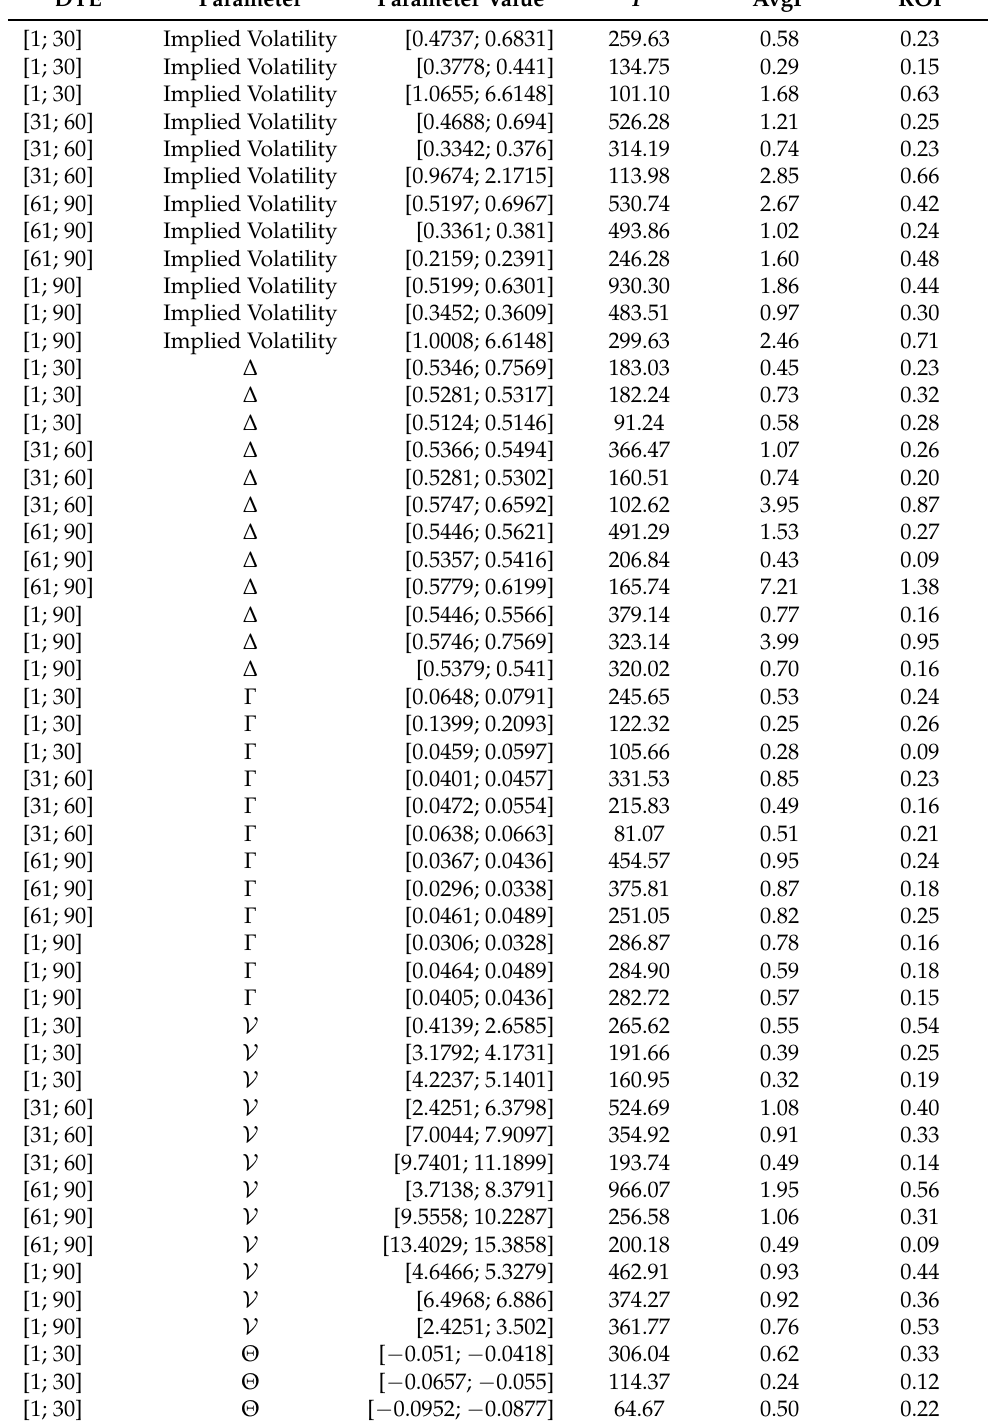
Table A1. Values of P (left axis) and AvgP and ROI (right axis) indicators obtained using 3 best-rated rules determined to maximize P